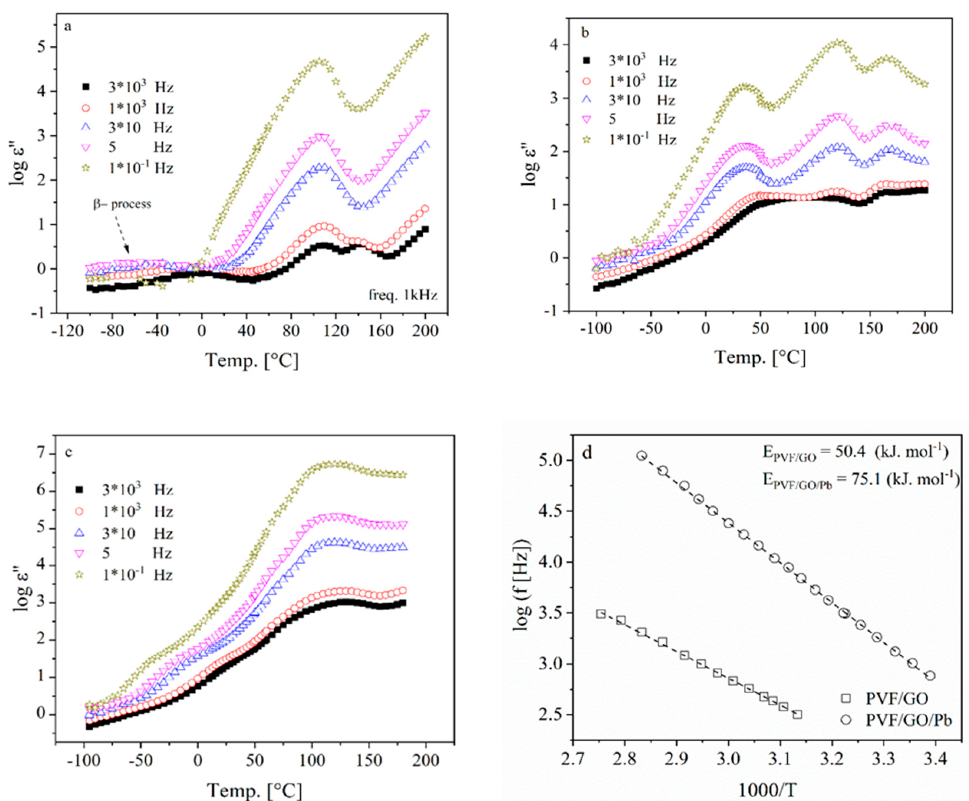
Figure 8. Dielectric loss ε ” versus temperature at different frequencies for pure PVF ( a ), PVF/GO ( b ) and PVF/GO/Pb composite samples ( c ). ( d ) Relaxation rate f β for the process at low temperature versus inverse temperature for: PVF (solid squares), PVF/GO (squares), and PVF/GO/Pb (circles) composites. The lines are fits of the Arrhenius equation to the corresponding data.